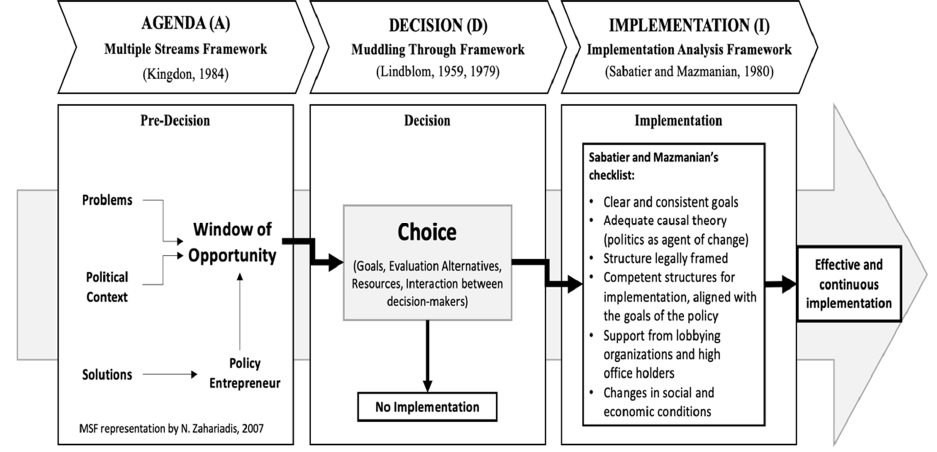
Figure 1. Adopted Framework. Source: [44].